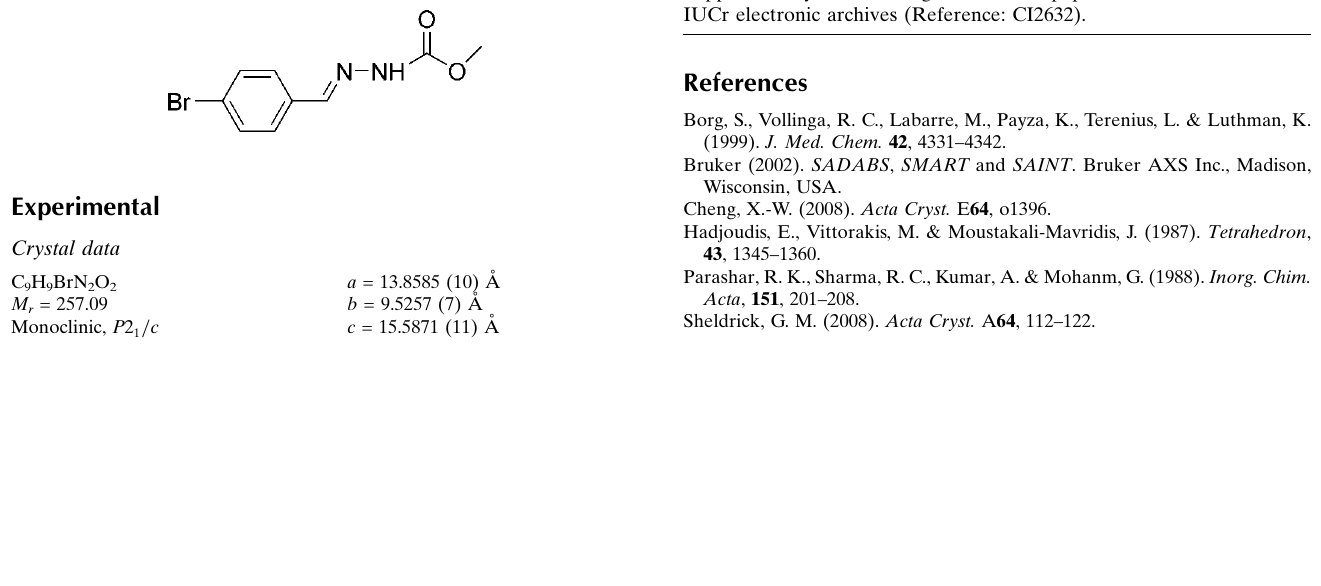
Related literature